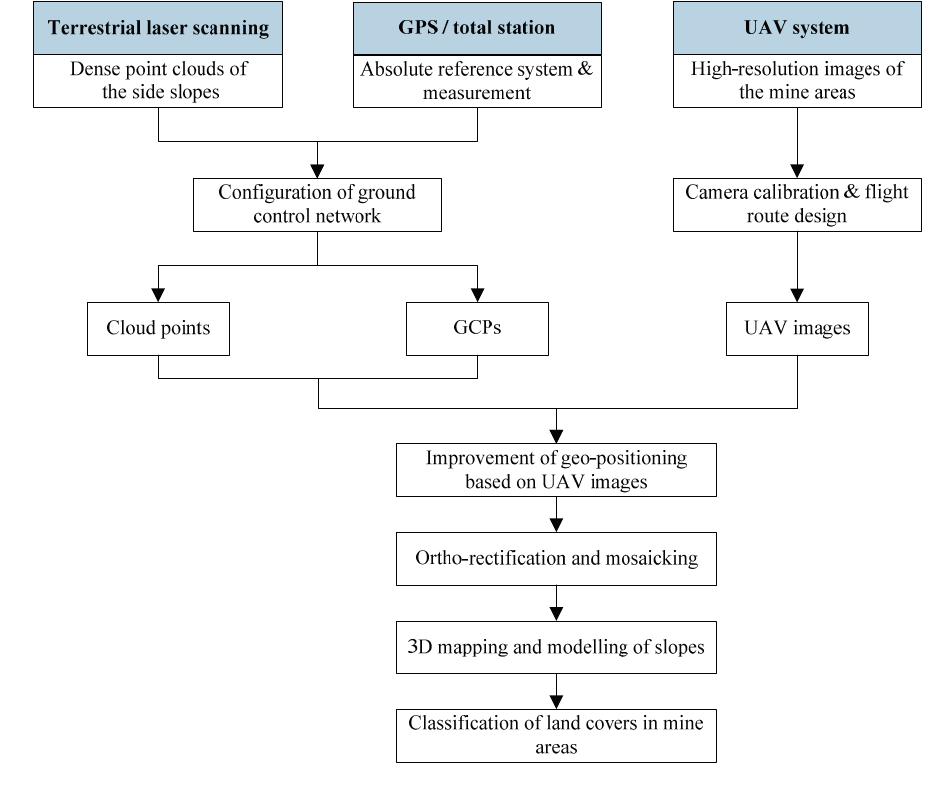
Figure 1. Entire workflow of the